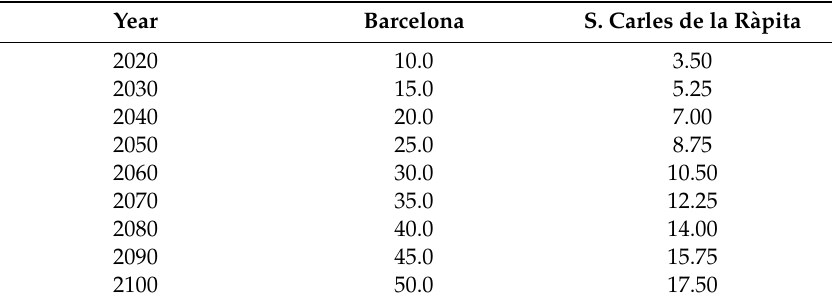
Table 1. Subsidence values (in cm) applied to the two ports located in